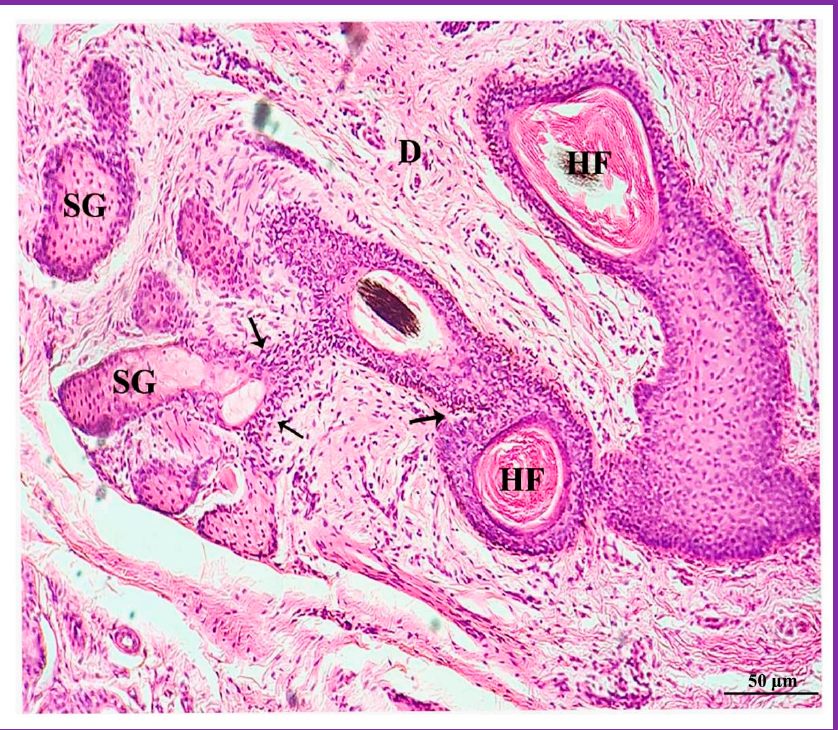
Figure 7. Photomicrograph of the interdigital sinus of Vembur sheep showing the branched excretory duct (thin arrow) of sebaceous glandular lobules (SG) connecting with hair follicles (HF). D: dermis.